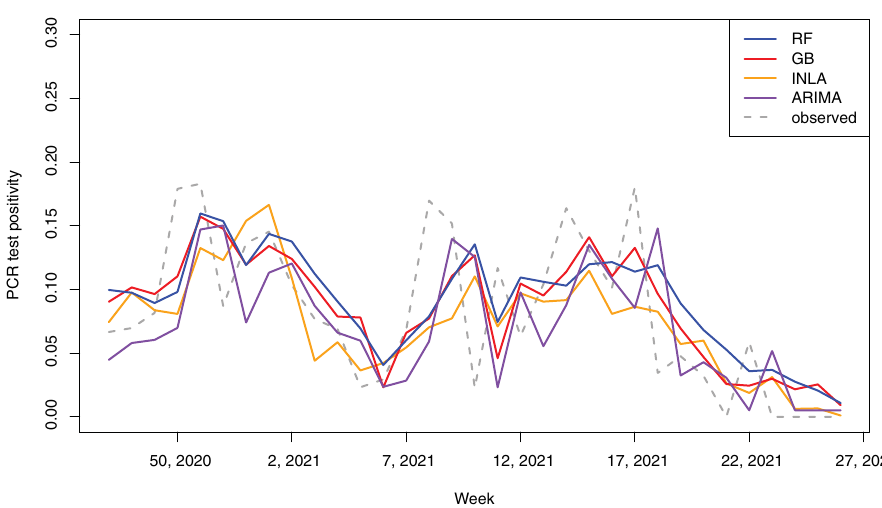
Figure 6. Time series of observed and predicted test positivity in Älvkarleby, a part of the region strongly affected by the pandemic.